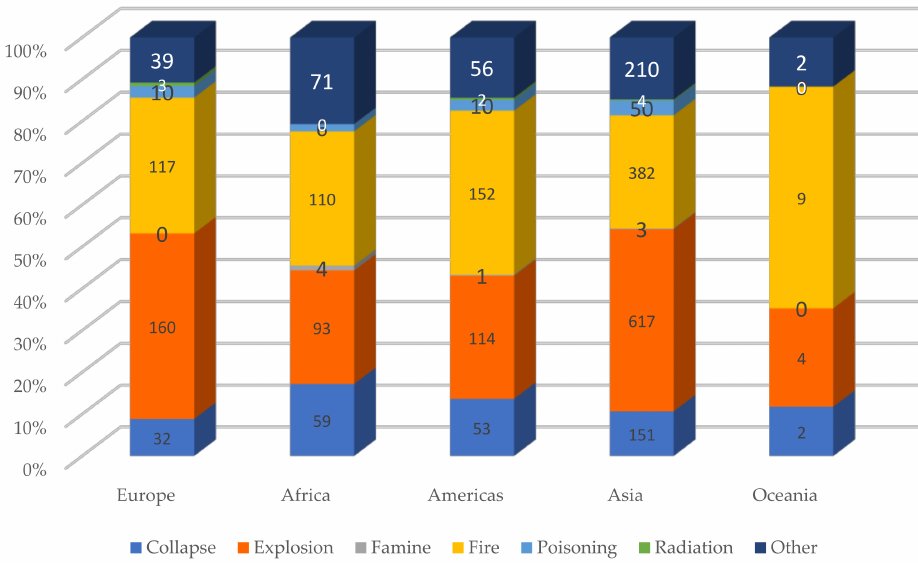
Figure 3. Distribution of disaster subtype according to the continent.